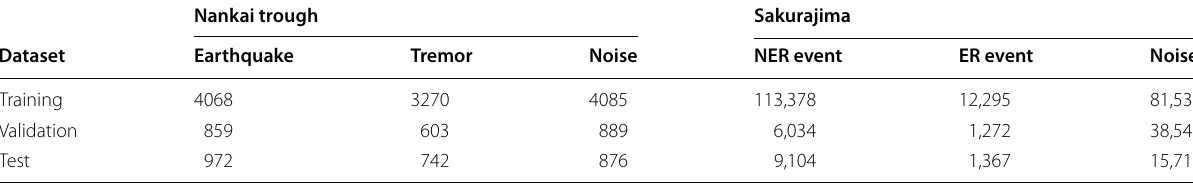
Table 1 Numbers of samples used for the training, validation, and test